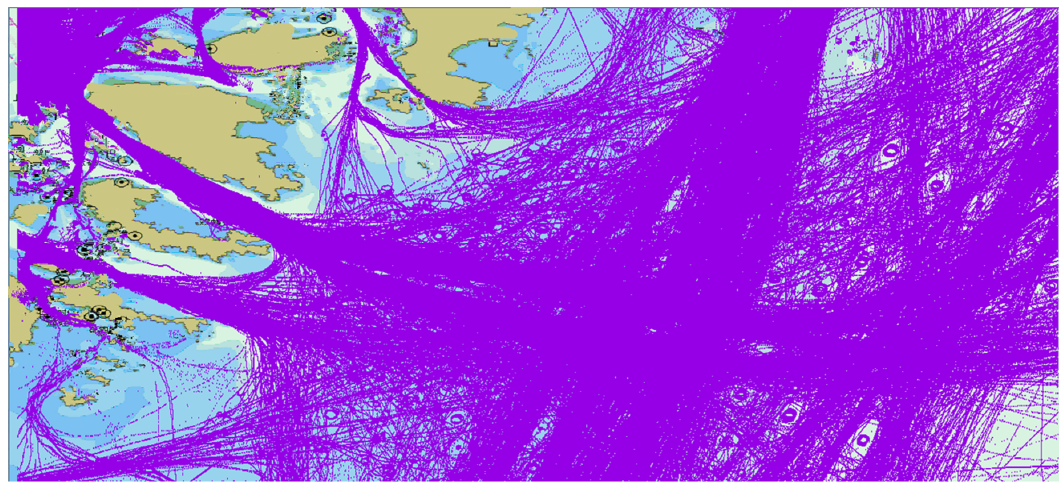
Figure 1. Automatic identification system (AIS) data trajectories obtained at Zhoushan Port.